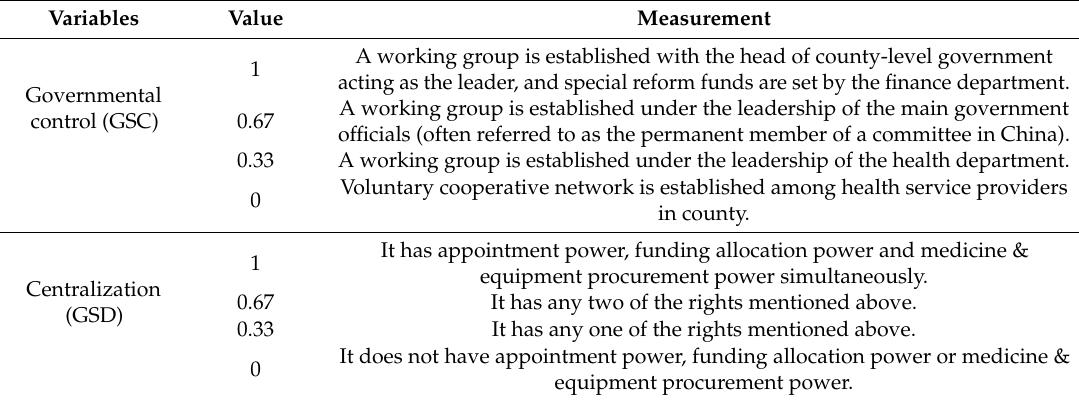
Table 5. Measurement and value of governmental control and